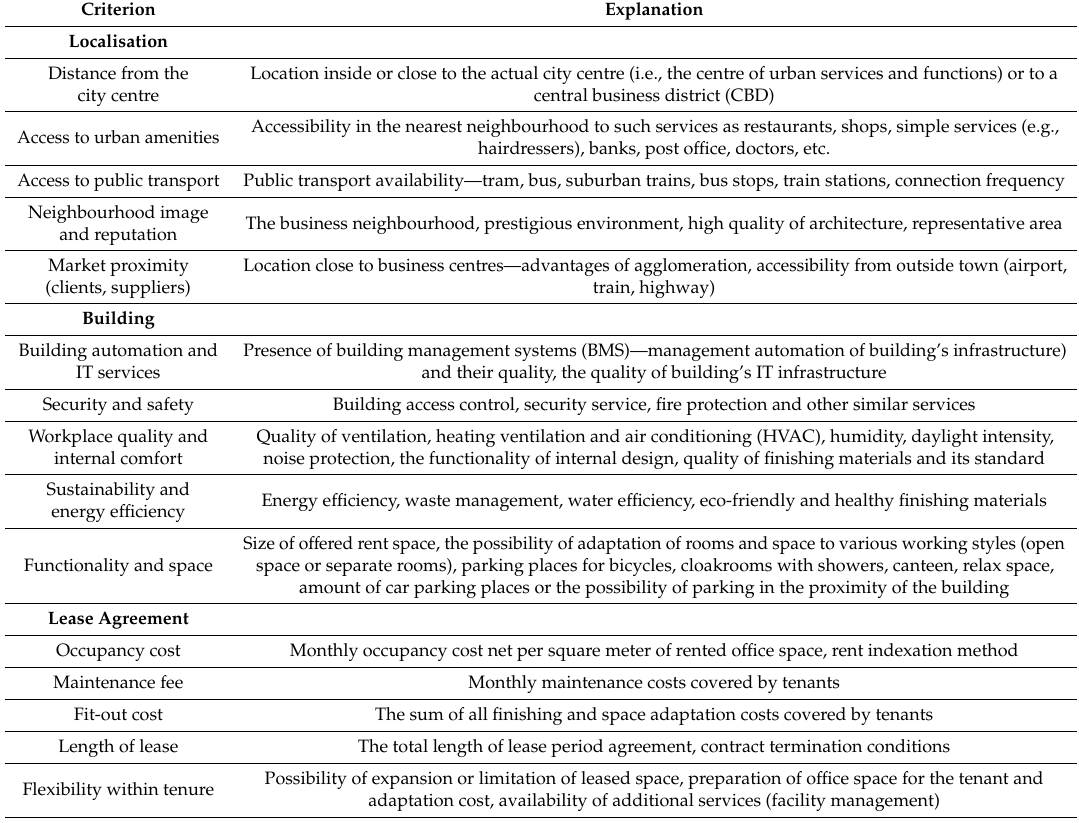
Table 1. Groups of decision criteria and their sub-criteria for choosing the o ffi ce space in